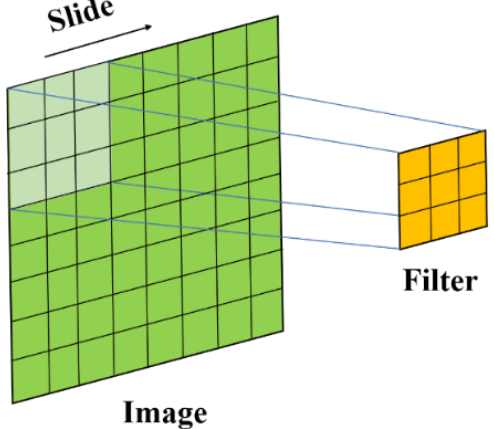
Figure 7. Filter extracting image features.